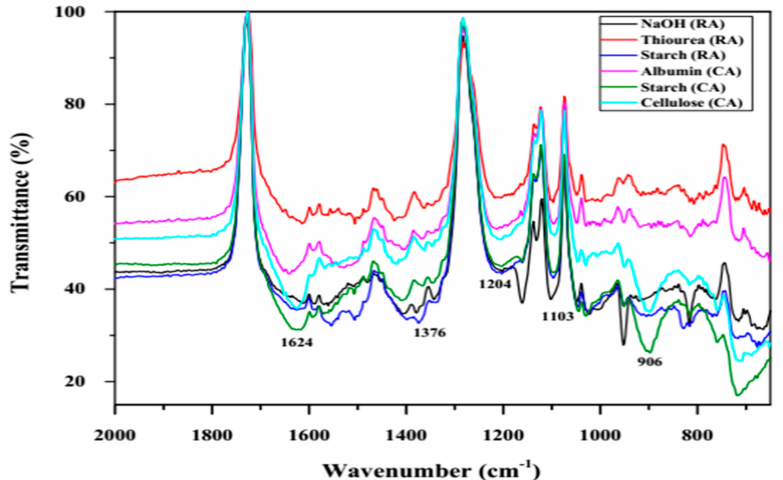
Figure 5. FT-IR cumulative spectra of the prepared ZnNPs for the mid-IR region (2000 to 650 cm − 1 wavenumbers) indicating variability in the occurrence of chemical functional groups.